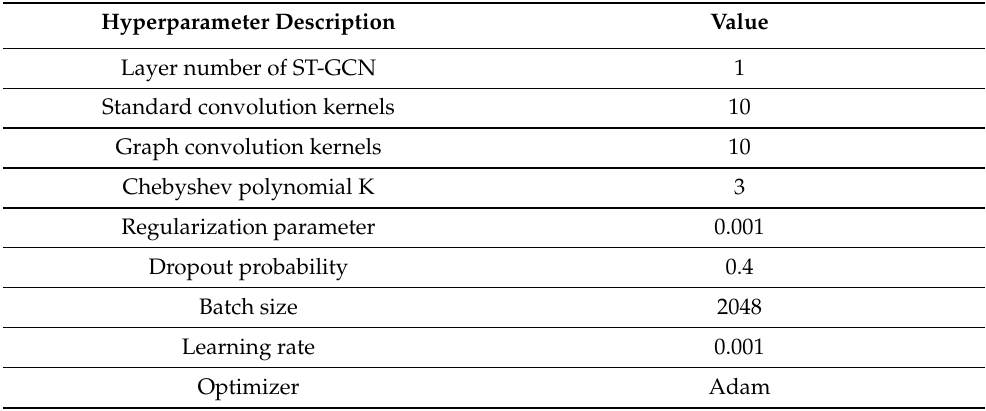
Table 3. Hyperparameters in the model that predicts emotions to Ekman’s model with additional neutral